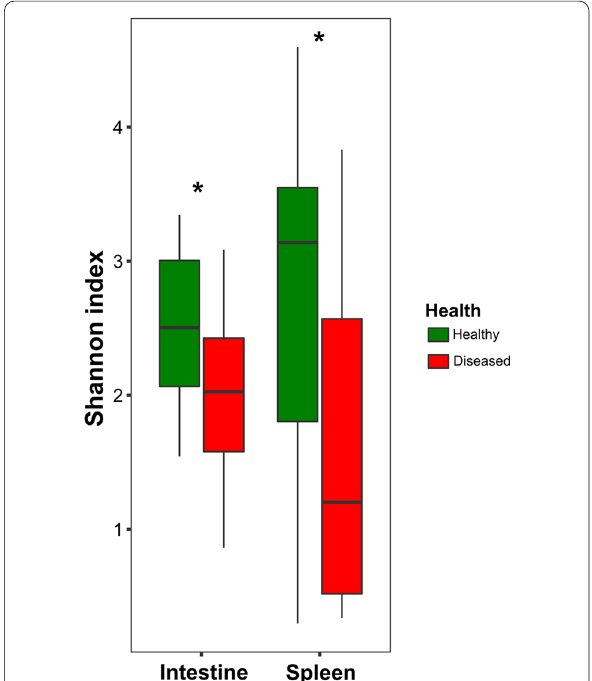
Fig. 2 α-diversity (Shannon index) of the microbiota composition (at the ASV level) for intestine and spleen samples from healthy and diseased fish. The diversity was significantly higher in healthy fish compared to the diseased fish in both the intestine and the spleen (ART ANOVA test, F 8.86, df 1, p 0.005). Asterisks denote = = = significant